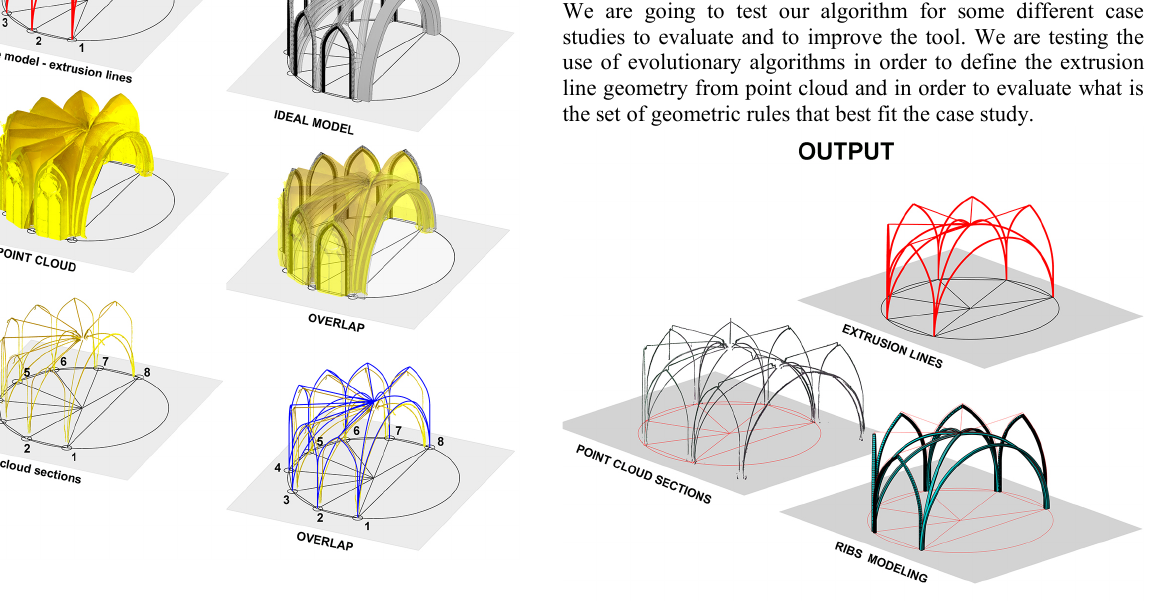
Figure 17 .Donnaregina apses vault: automatic ribs